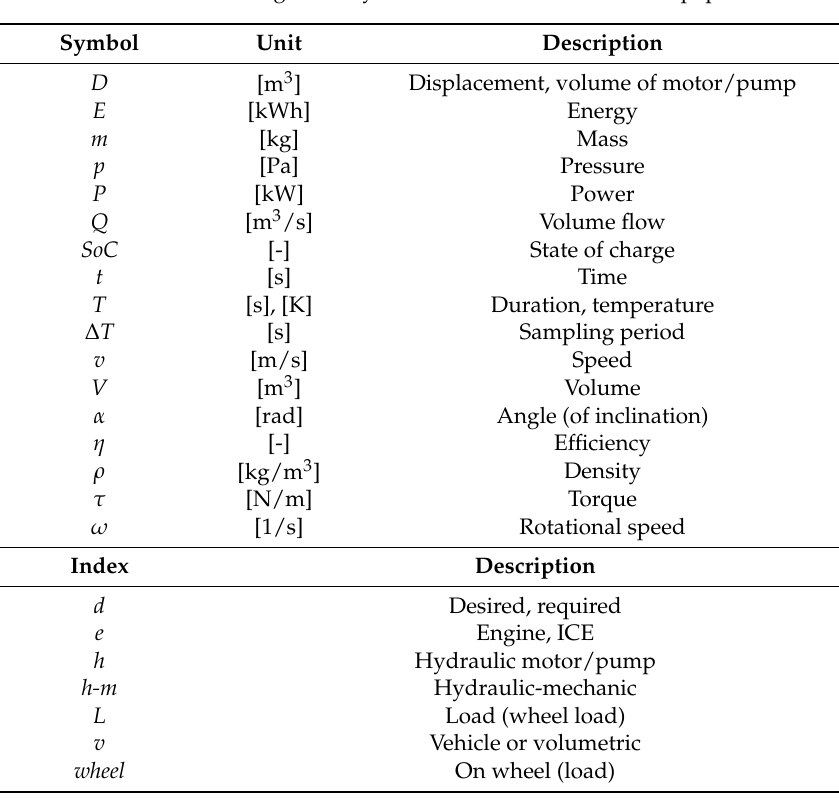
Table A3. List of general symbols and indexes used in the